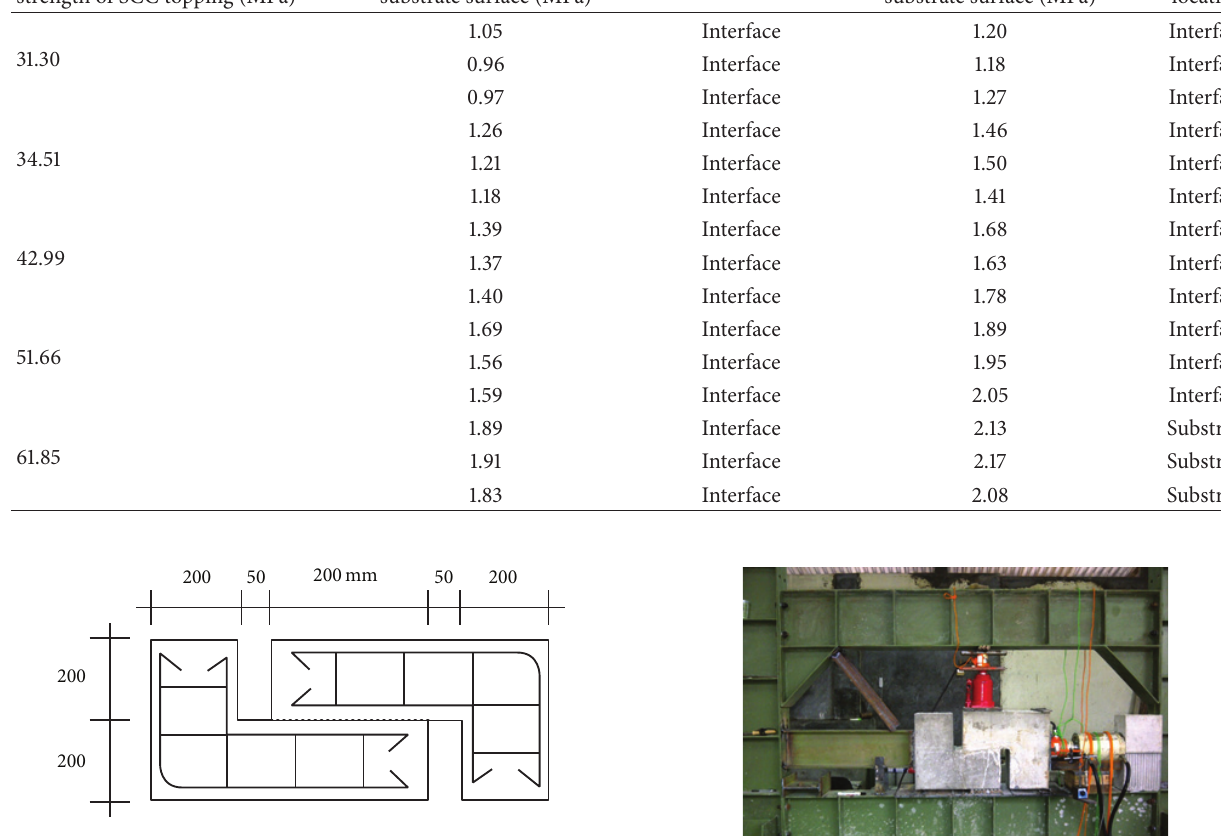
Figure 4: Detailed dimensions of specimens for double L-shaped shear test.